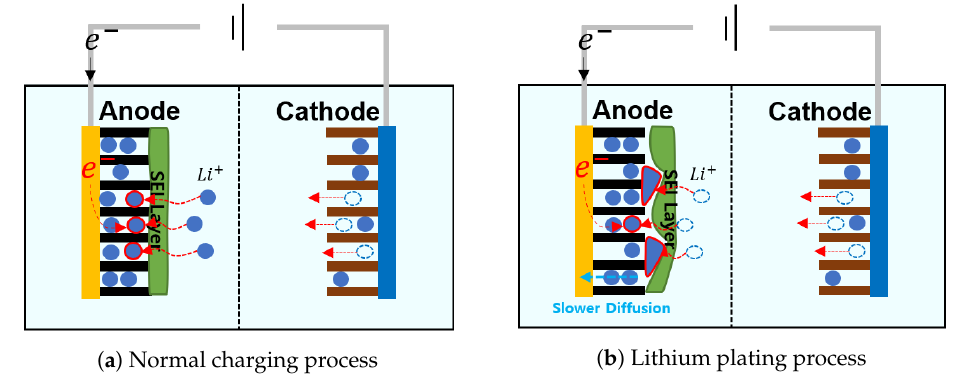
Figure 3. Charging processes in two conditions. ( a ) normal charging process without lithium plating effect; ( b ) charging process with lithium plating effect due to a slower diffusion in a low